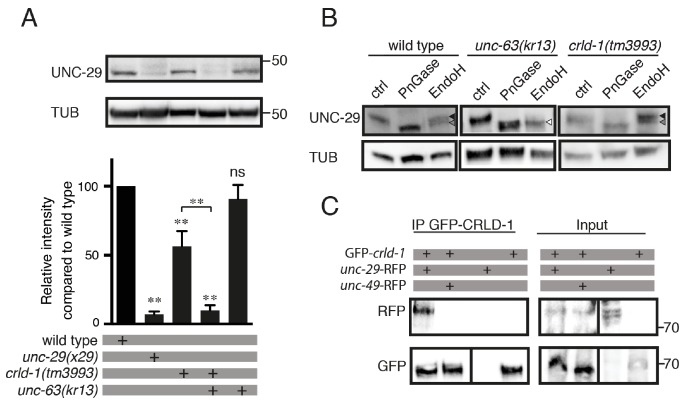
CRLD-1 is required for the stability of unassembled L-AChR subunits.(A) L-AChR expression is reduced in crld-1(tm3993) mutants. Levels of unassembled UNC-29 L-AChR subunits detected in unc-63(kr13) are further decreased in unc-63(kr13);crld-1(tm3993) double mutants. UNC-29 levels were quantified by western blot using anti-UNC-29 antibodies and normalized to tubulin levels. Significance is indicated compared to the wild type. The significance between unc-63(kr13);crld-1(tm3993) and crld-1(tm3993) is indicated by an horizontal line. Five independent experiments were quantified (mean ± SEM). p=0.6825, ns (not significant); **p=0.0079; after Bonferroni correction, Mann-Whitney test. TUB = tubulin. (B) Remaining L-AChRs exit the ER in crld-1(tm3993). Treatments with EndoH or N-Glycosidase F (PNGase) were performed on protein extracts of mixed-stage animals before SDS-PAGE analysis. Black arrowheads indicate glycosylated forms resistant to EndoH, gray arrowheads indicate glycosylated forms partially resistant to EndoH, and white arrowheads indicate deglycosylated forms sensitive to EndoH. (C) CRLD-1 interacts with UNC-29 subunit of L-AChR in vivo. gfp-crld-1(kr298) animals were crossed with rfp-unc-29(kr208) or rfp-unc-49(kr306) to co-express CRLD-1 with RFP-tagged AChR or GABAAR subunits, respectively. Immunoprecipitation of GFP-CRLD-1 using GFP-Trap beads co-immunoprecipitated RFP-UNC-29, but not UNC-49-RFP. As a control, GFP-CRLD alone was not immunoprecipitated by anti-RFP antibody. A vertical line indicates that the lanes are not adjacent in the gel.